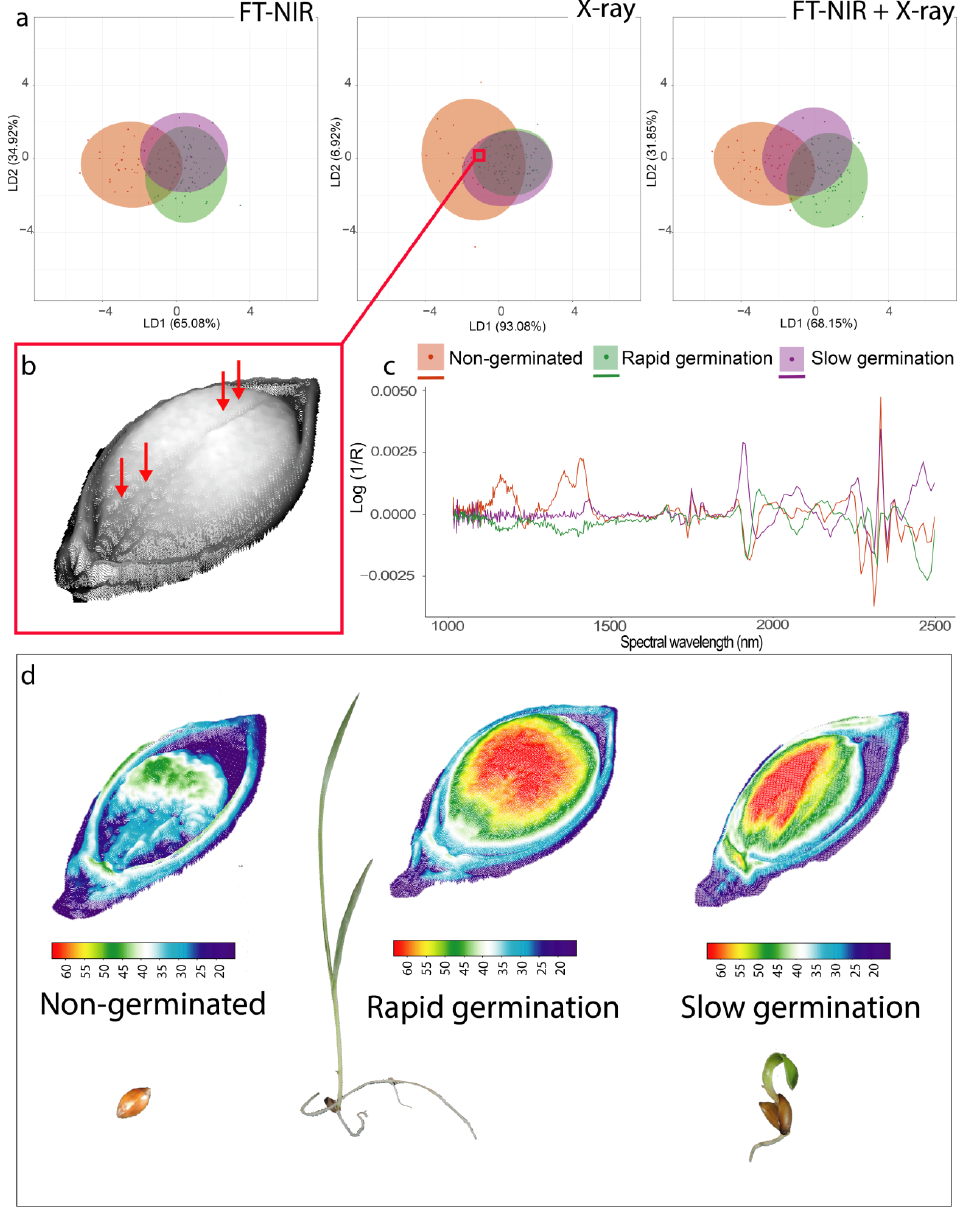
Figure 2. ( a ) Score plots of the linear discriminant analysis (LDA) for quality classification of U.